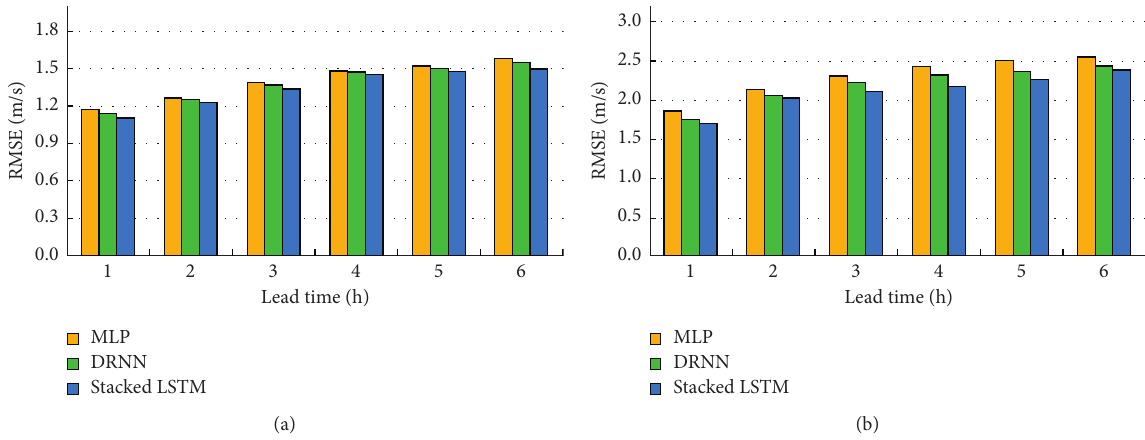
Figure 9: Performance levels of neural network-based predictions for lead times between 1 and 6 h using a training-validation set for the (a) Taipei Station and (b) Yilan